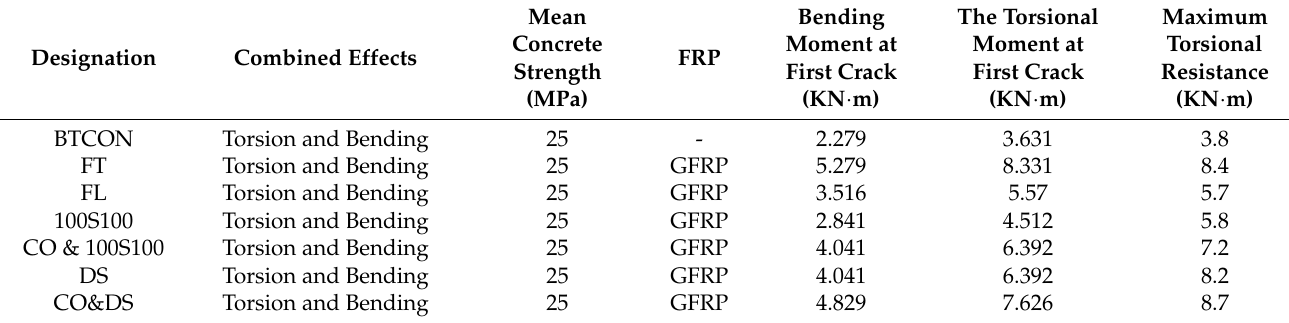
Table 3. Summary of beam